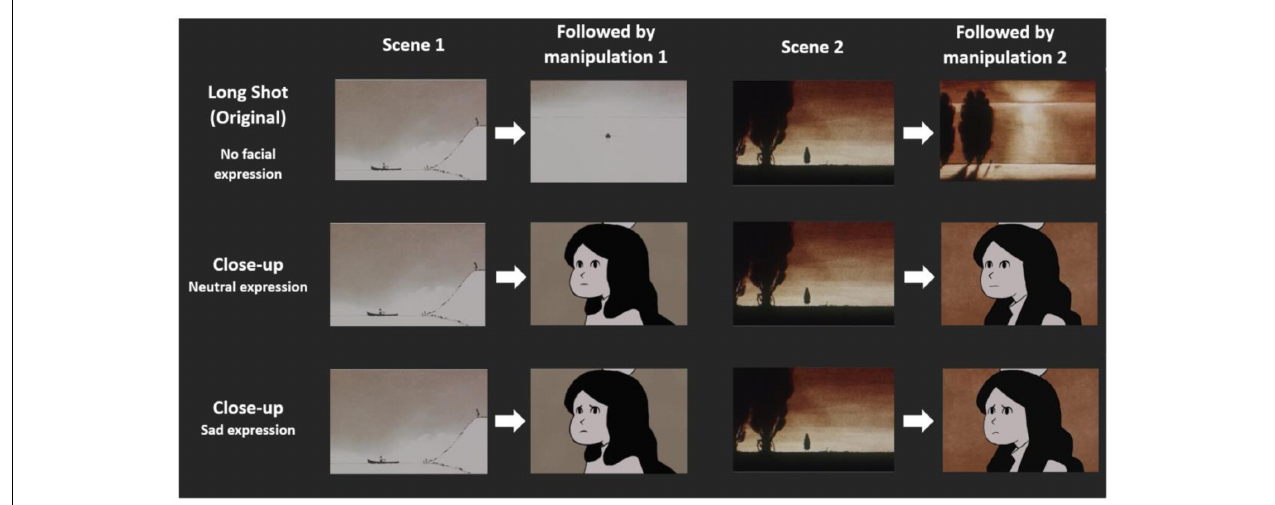
FIGURE 1 | Images of character depiction by condition. Each row depicts an experimental condition. Participants watched a sequence containing two scenes. Depending on the condition, the shot presented in the first and third column (Scenes 1 and 2) was followed by a different shot. Condition 1 (top row) = Long shot is followed by another long shot with no visible facial expression; Condition 2 (middle row): Long shot is followed by a close up shot with neutral facial expression; Condition 3 (bottom row): Long shot is followed by a close-up shot with sad facial expression.